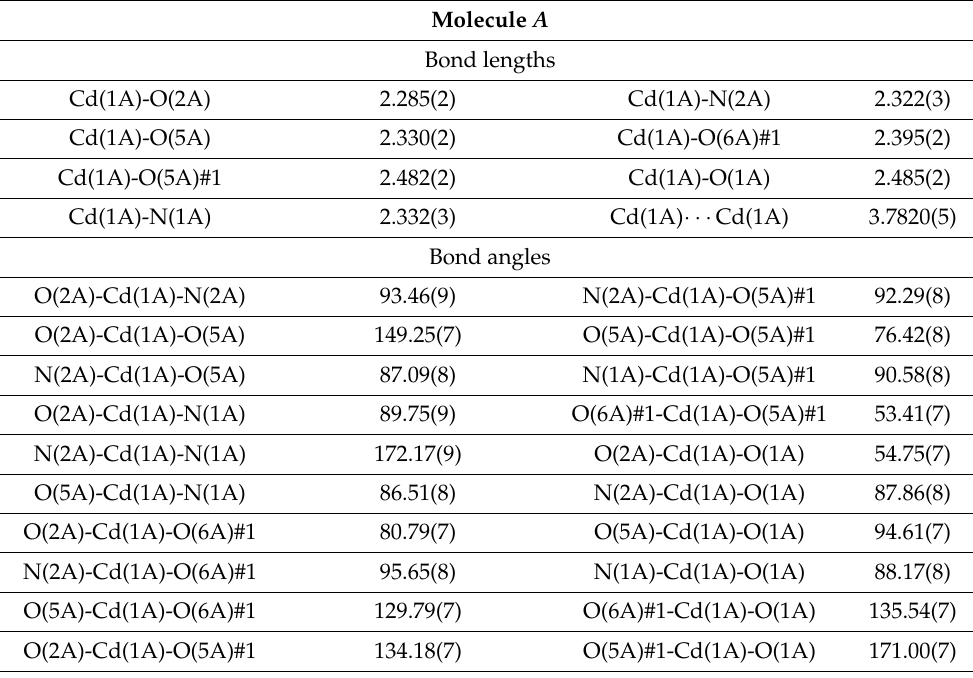
Figure 5. Molecular structure of the crystallographically independent dimeric units in complex 4 . Units A and B ( a ) with their corresponding Cd(II) cores ( b ). Table 4. Bond lengths (Å), bond angles (°) and intramolecular π ··· π interactions in 3 .